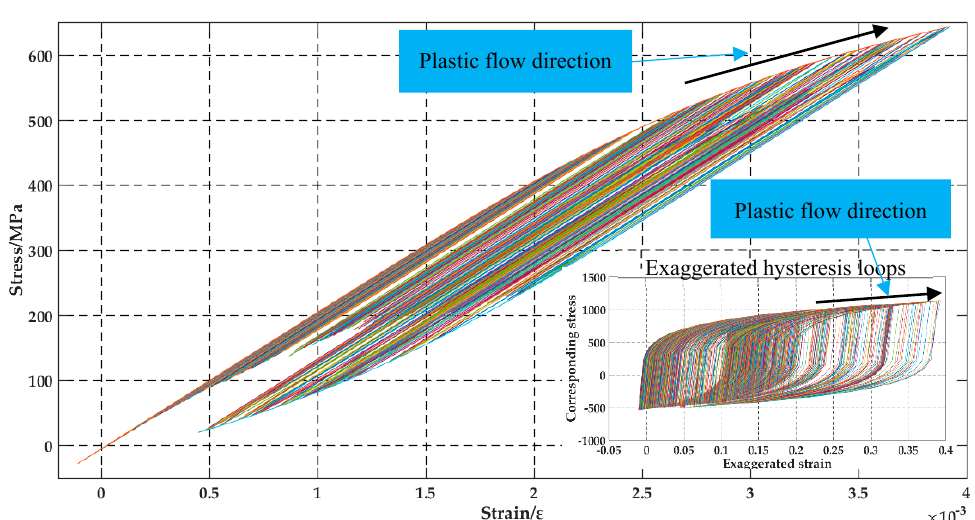
Figure 14. Strain stress response curve (“strain stationary” phase for testing point 3#).